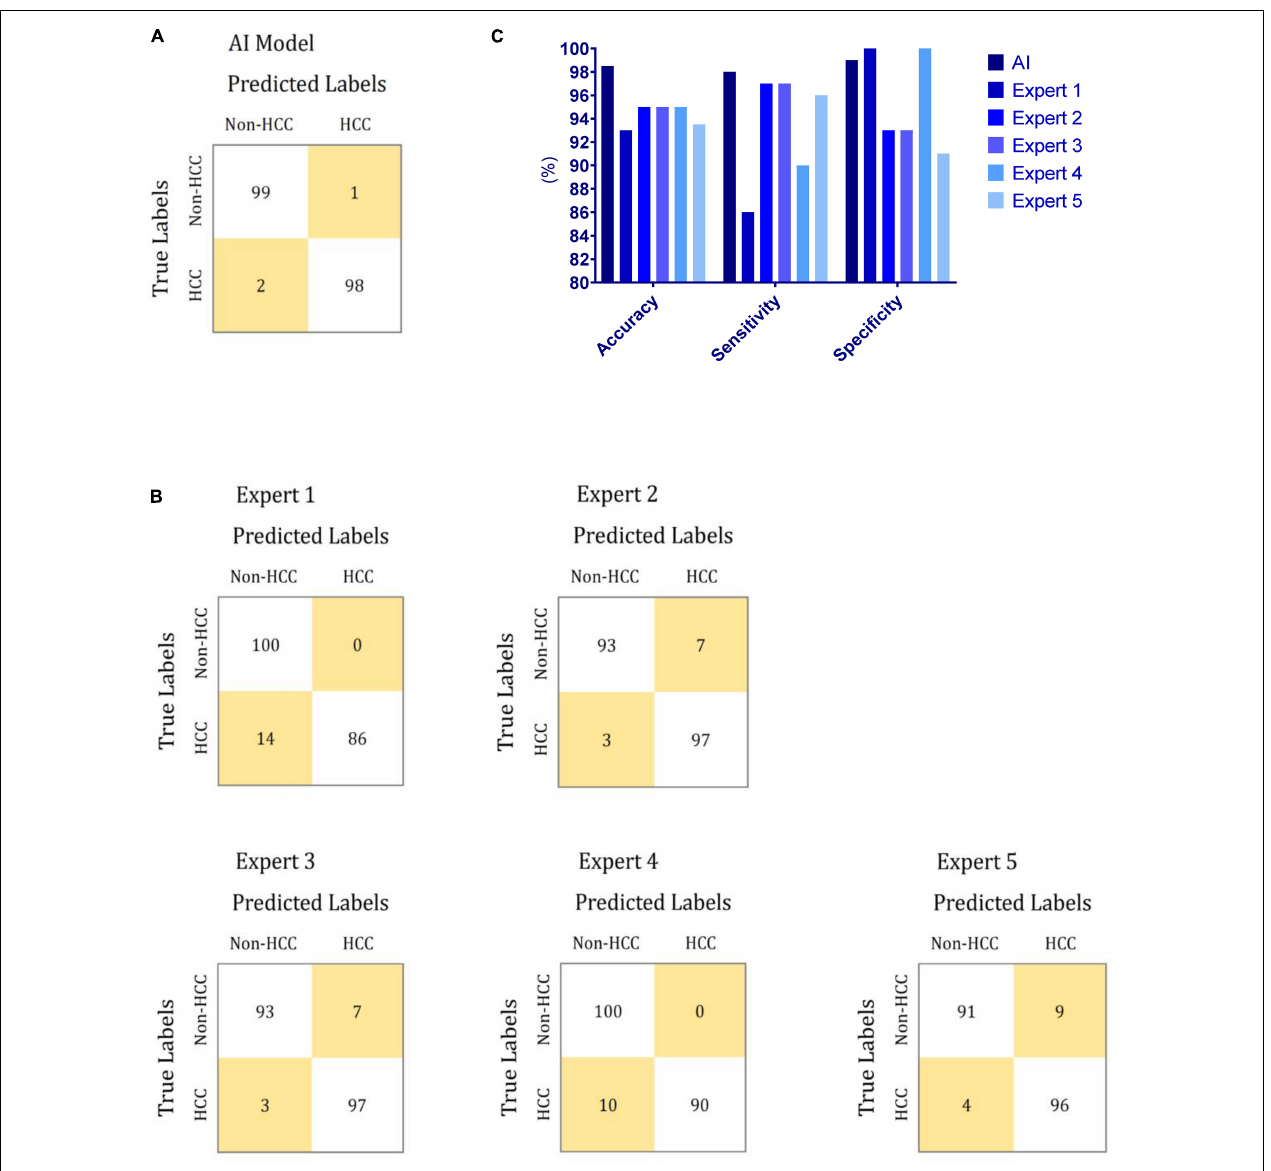
FIGURE 2 | Performances of the proposed AI model and human experts during human–machine comparison. (A) Confusion matrix of the proposed AI model for HCC diagnosis. (B) Confusion matrix of human experts for HCC diagnosis. (C) Comparison between the performances of the proposed AI model and human experts for HCC